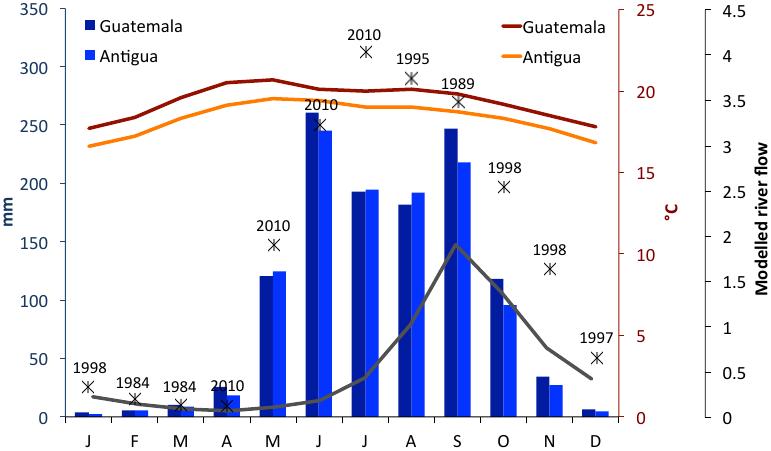
Figure 3. Averaged monthly rainfall and temperature for the cities of Guatemala and the closest meteorological station to Antigua Guatemala (called Suiza Contenta) for the period 1980–2010 (INSIVUMEH). The grey line shows an estimation of the monthly average run-off per month of the Pensativo River for the 1981–2010 period based on results from the ORCHIDEE land surface model. The asterisks show the highest estimated river flow per month and the year in which it happened. All the highest estimated river flow values of the rainy season correspond to La Niña